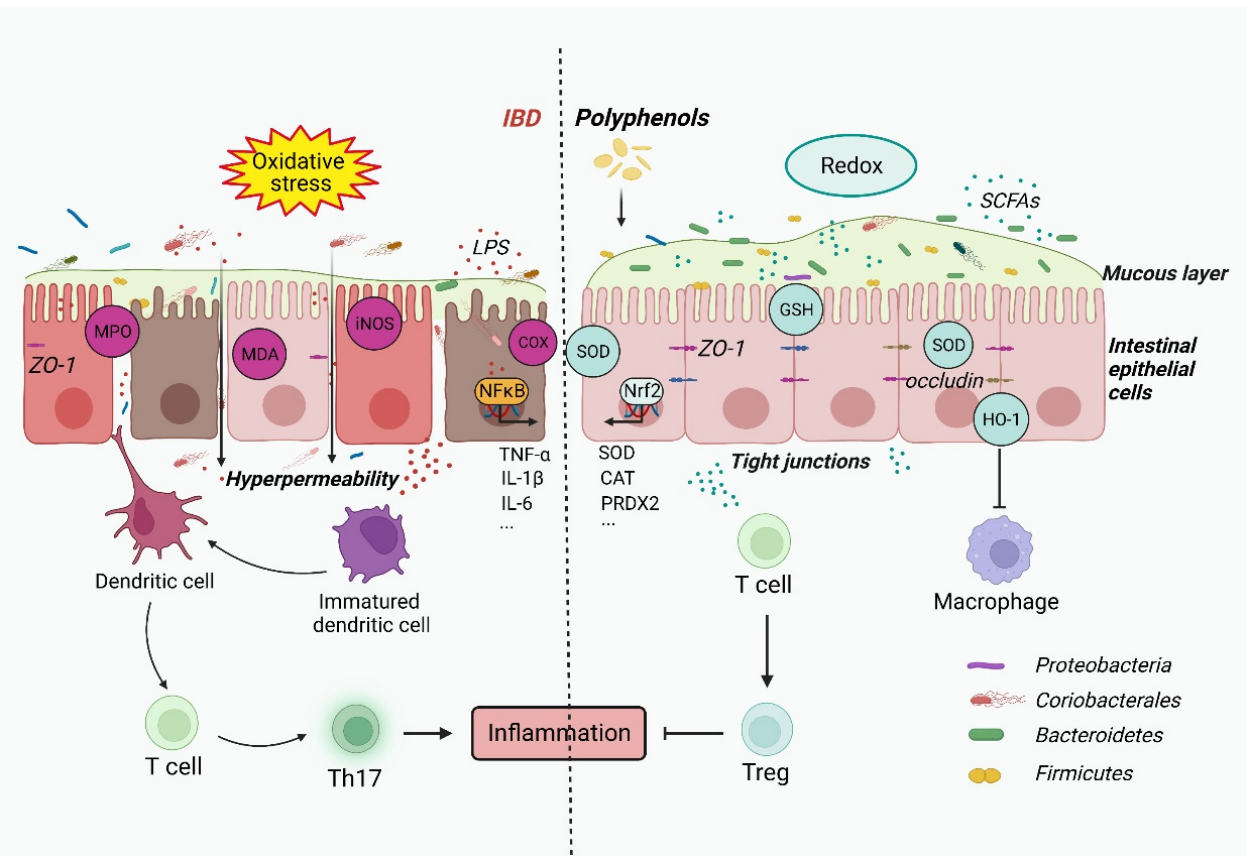
Figure 4 . Polyphenols regulate immune response and oxidative stress to treat IBD. Polyphenol treatment reinforces the intestinal mucosal barrier by enhancing the tight junction proteins. In addition, polyphenols can eliminate ROS and evoke antioxidative signaling pathways to alleviate oxidative damage. Similarly, administration with polyphenols can regulate the differentiation of immune cells and attenuate active immune response, thus inducing IBD remission.